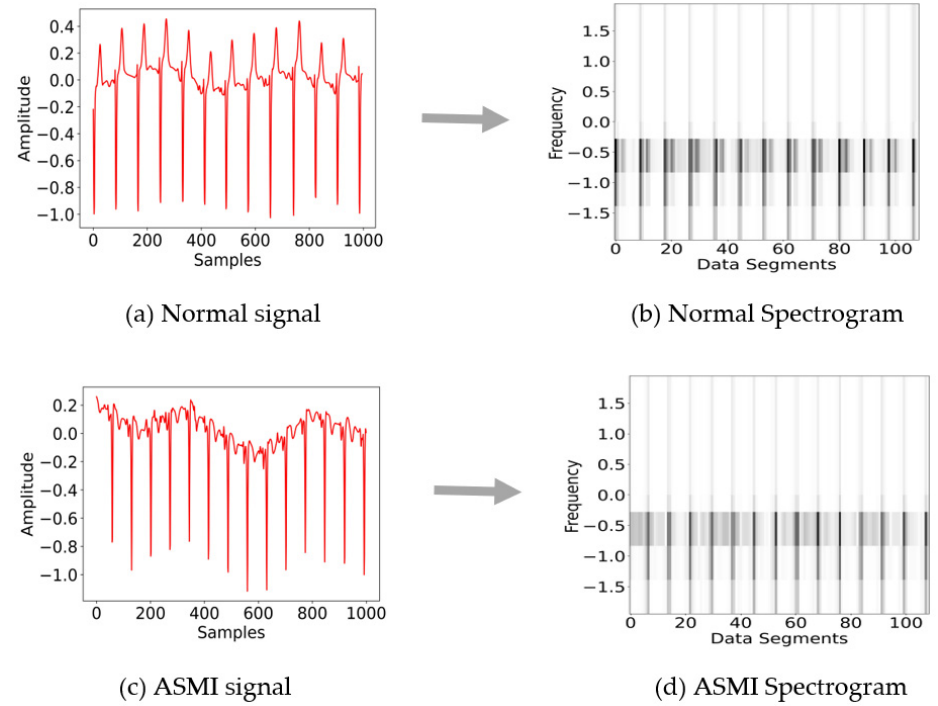
Figure 2. ( a ) Normal ECG signals: x -axis (samples/datapoints), y -axis (frequency in Hz); ( b ) raw signal transformed into spectrogram: x -axis (data segments), y -axis (frequency in Hz); ( c ) ASMI ECG signals: x -axis (samples/datapoints); ( d ) raw signal transformed into spectrograms: x -axis (data segments), y -axis (frequency in Hz).